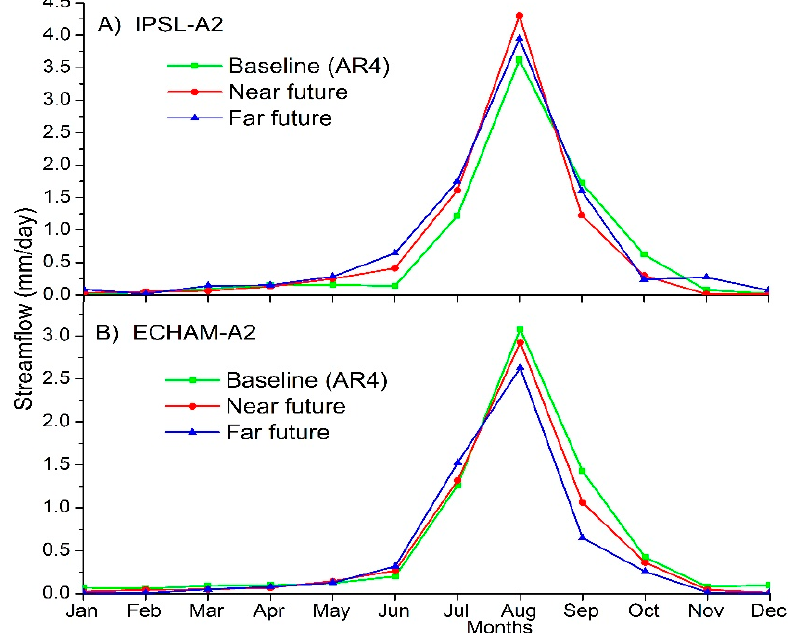
Figure 15. Projected monthly streamflow compared to the baseline: ( A ) results of ECHAM-A2 for both projection periods, and ( B ) results of IPSL-A2 for both periods.